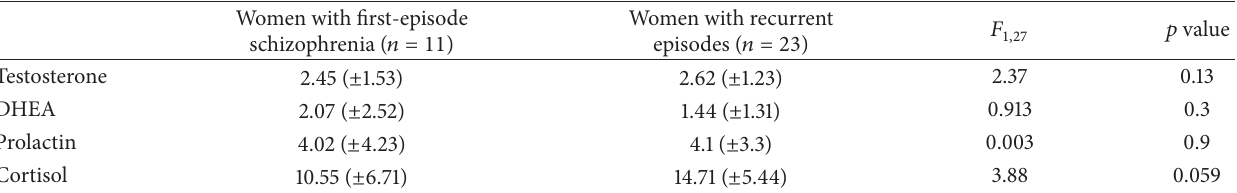
Table 6: Comparison using multivariate analysis of variance (MANOVA) of serum hormones levels in women with first-episode schizophrenia disorder and recurrent episodes.